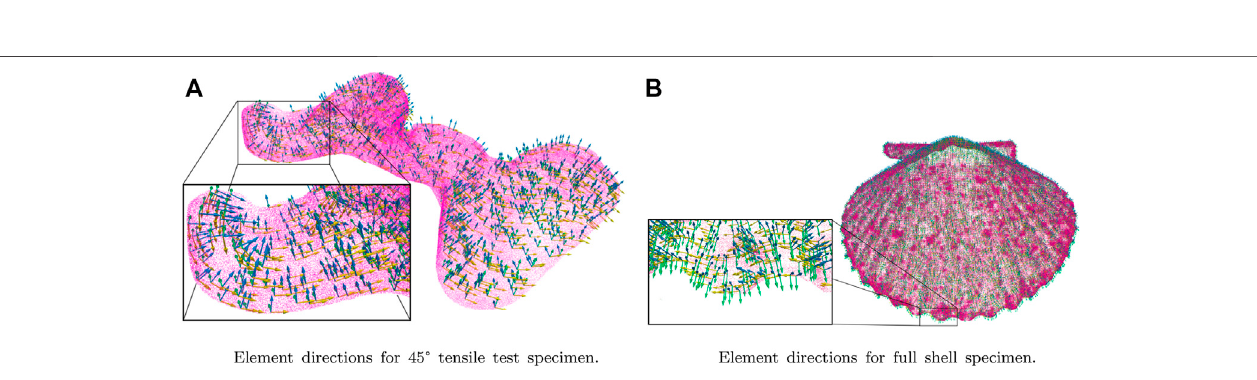
FIGURE4| Elementdirections fi ttingformeshesusedinFEMsimulations:Theboxesareshowntheorientationsoftheparticular coordinatedsystemconcerninga global orthotropic behavior. (A) shows the element directions for the 45 ° tensile test specimen, and (B) shows the element directions for the entire shell specimen.